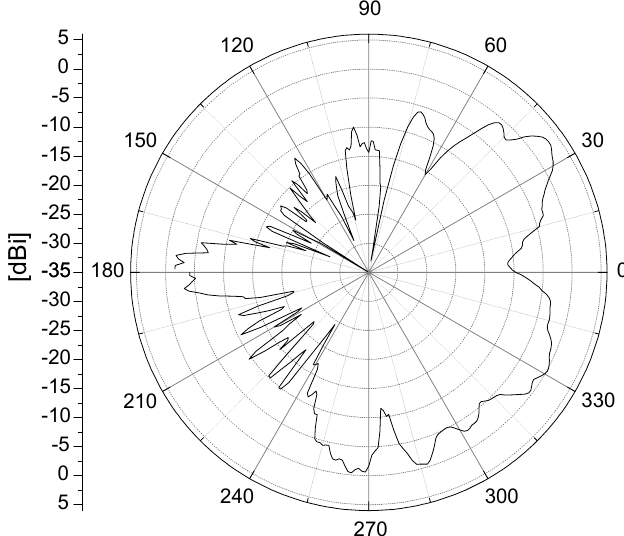
Figure 1. Test scenarios: ( a ) Yngve, a T-junction with buildings only in two corners. ( c ) Xerxes, an X-junction with buildings in all four corners. ( b ) shows the configurations of the two groups where the red dots show the antenna location(s) on each vehicle.